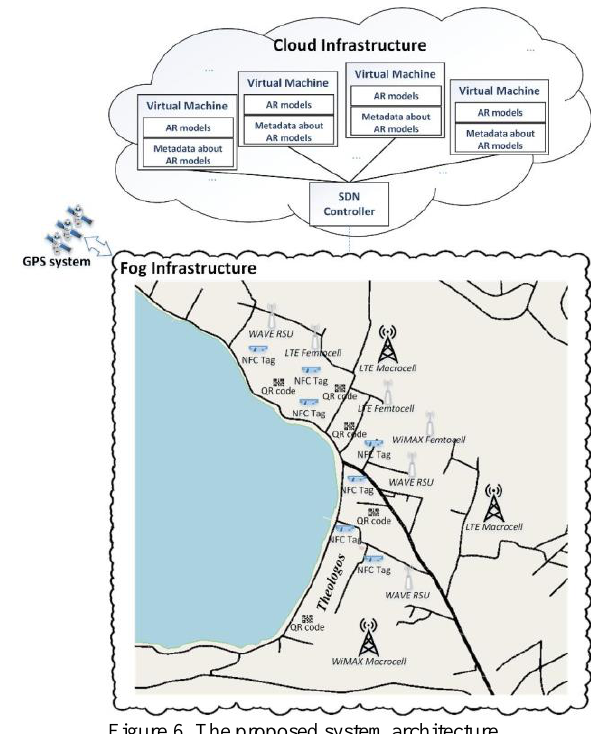
Figure 6. The proposed system